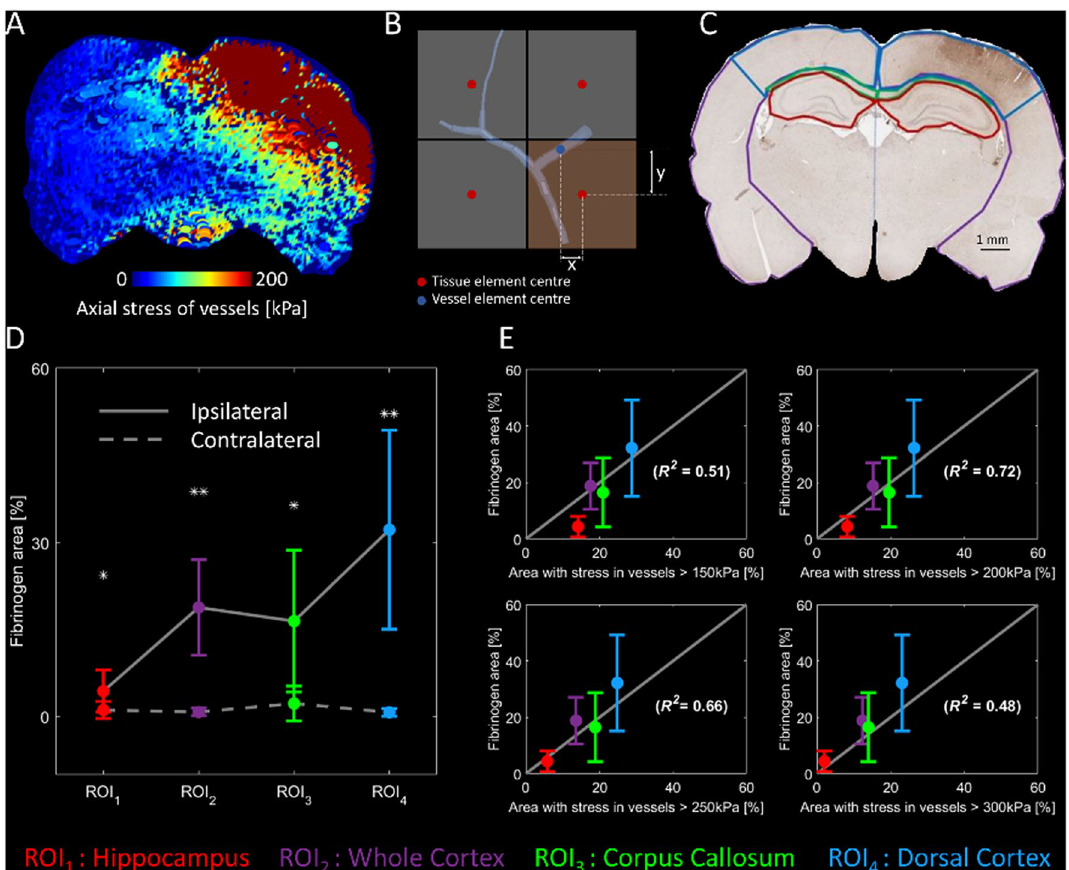
Figure 2. Quantitative comparison of numerical simulation and experiments. ( A ) Vessels’ axial stress mapped on the brain tissue. ( B ) For quantitative comparison between the fibrinogen extravasation and the stress in the angioarchitecture, stress of beam elements of the vasculature in the domain of tissue elements are mapped to the corresponding solid element. ( C ) Four segments of the brain tissue used for quantifying fibrinogen extravasation. ( D ) The fibrinogen extravasation is significantly higher in the ipsilateral hemisphere (* and ** indicate p < 0.05 and p < 0.005 respectively). ( E ) Correlation between the vessels’ axial stress and fibrinogen extravasation [error bars in ( D,E ) showing the standard deviation of the results among all tested